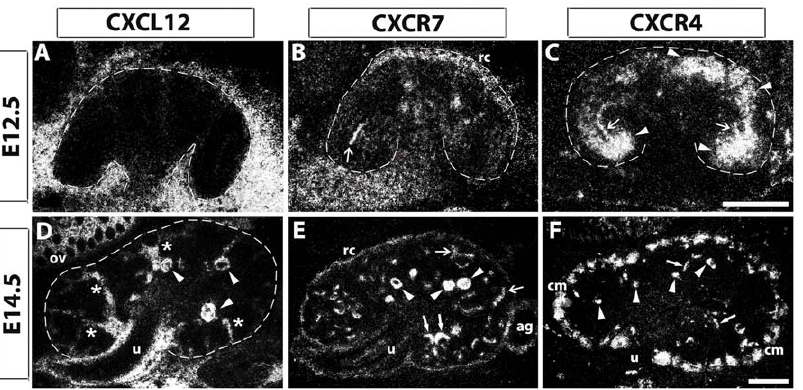
Figure 1. Patterns of CXCL12, CXCR7, and CXCR4 mRNAs in the early developing kidney. Adjacent kidney sections were hybridized with radiolabeled antisense riboprobes for CXCL12, CXCR7, and CXCR4 at E12.5 and E14.5. ( A , D ) CXCL12 expression pattern changed remarkably from E12.5 to E14.5 as no CXCL12 mRNA could be detected within the E12.5 kidney. At E14.5, CXCL12 signals are present in the kidney in stromal cells (asteristics in D), around the ureter (u) as well as in glomeruli (arrowheads in D). ( B , E ) CXCR7 mRNA is expressed in the region of the renal capsule (rc) and ureter at both indicated embryonic stages. The gene is also active in some ureteric buds (open arrows in B, E), immature glomeruli (closed arrows in E), and mature glomeruli (arrowheads in E). ( C , F ) CXCR4 mRNA is highly expressed in mesenchymal cells below the rc region at E12.5 (arrowheads in C) as well as in the cap mesenchyme at E14.5 (cm in F). CXCR4 is also expressed in some ureteric buds at E12.5 (open arrows in C). At E14.5, CXCR4 expression is found in presumptive blood vessels (closed arrows in F) and glomerular tufts (arrowheads in F). Allocation of detection signals to renal structures was performed using counterstaining with hematoxylin & eosin. ag, adrenal gland; ov, ovarium; Scale bars correspond to 100 m m. doi:10.1371/journal.pone.0042814.g001 CXCL12 labeling (Table 1). During progression of mesenchymal- to-epithelial transition, transcription of the CXCL12 gene was turned on at the pretubular aggregate stage and CXCL12 expression remained high at subsequent nephrogenic stages (Table 1). In the vascular cleft of S-shaped bodies, hybridization signals were detected for CXCR4 (Figure 2D 9 : arrows) and CXCL12 (data not shown) but not for CXCR7 (Figure 2C 9 ). Taken together, CXCR7 and CXCR4 showed similar time dependent expression in the tip of the ureteric bud. Downregu- lation of CXCR4 in the ureteric bud was accompanied by